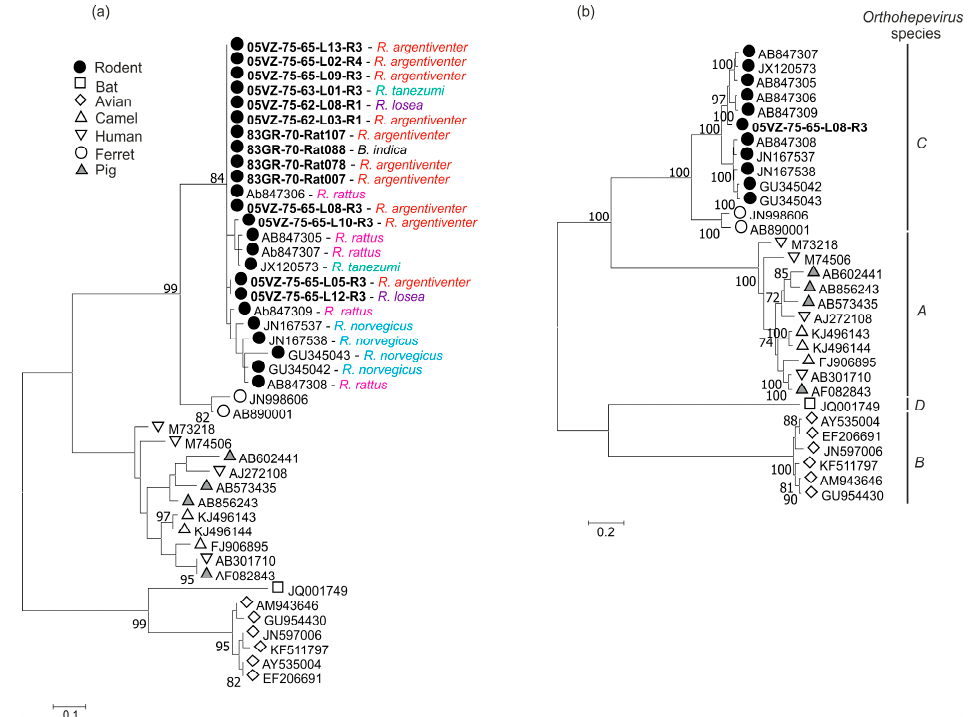
Figure 3. Maximum likelihood trees of ( a ) the screening fragment and ( b ) the ORF1 of hepeviruses using the best-fitting models of LG+G+I and LG+G+F, respectively. Rodent species are shown. Labels for sequences obtained in this study are highlighted in bold. Bootstrap support values of ≥ 70% are shown. The trees were drawn to scale; bar, estimated number of substitutions per site.